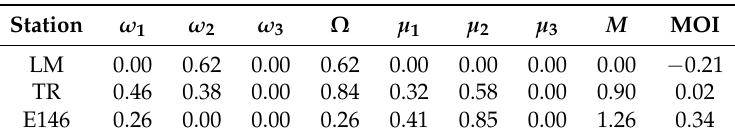
Table 5. Marsh-to-Ocean Index (MOI) values over the period 1 January 2014–31 December 2016 at stations LM, TR and E146 relative to the ocean-dominated station at Buoy Key (BK) and the marsh-dominated station at